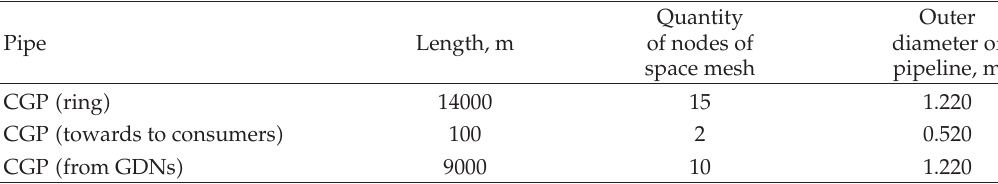
Table 2: Pipeline parameters in